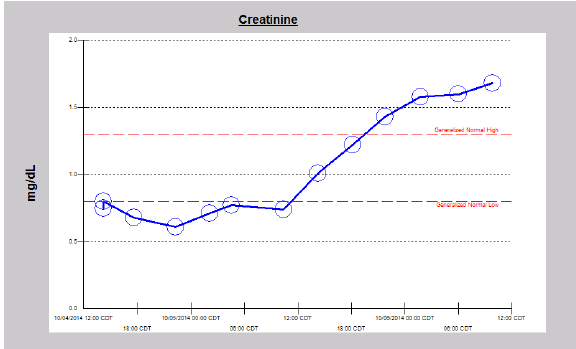
Figure 3. Trajectory of blood ABG pH during the first 10 days of the admission with intentional ethylene glycol intoxication.